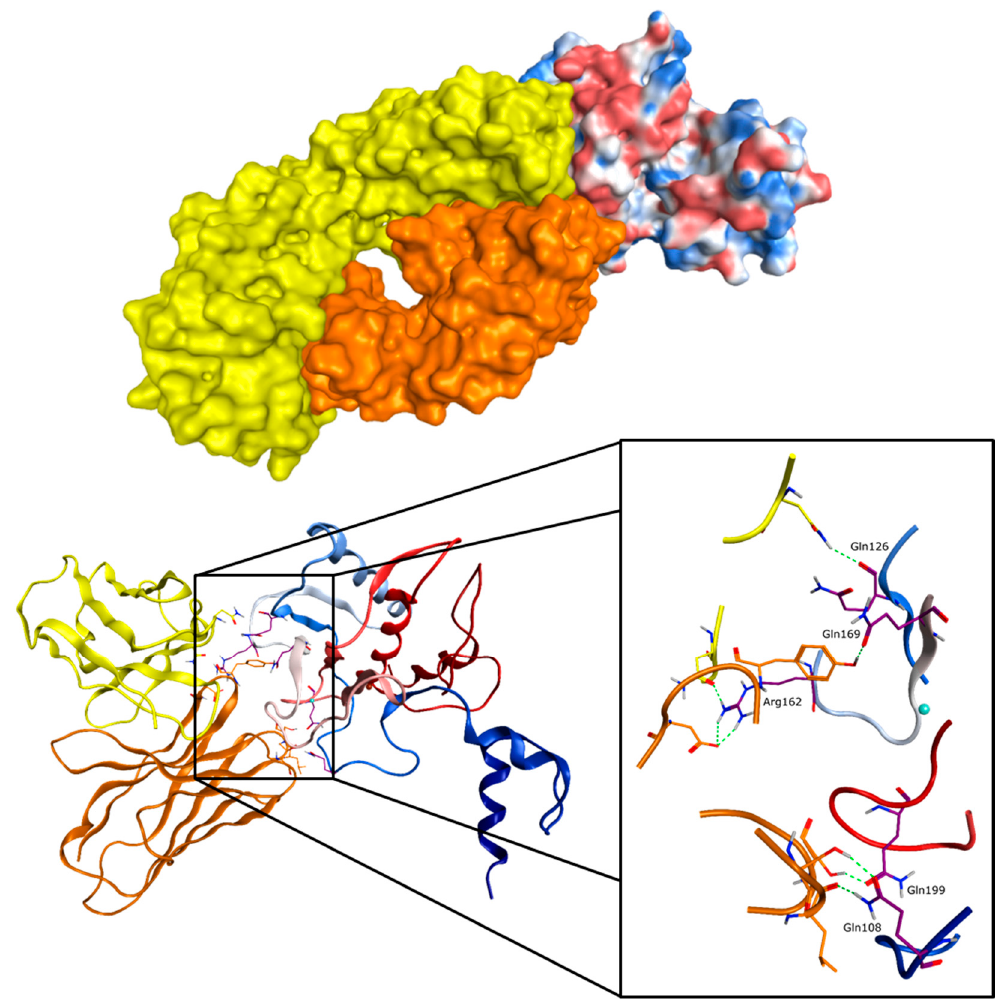
Figure 7. Crystal structure of GS-5745 Fab’ fragment complexed to MMP-9 and a close-up of the interaction site with the interacting side chains of MMP-9 (PDB ID: 5TH9 [19], GS-5745 Fab fragments in yellow and orange, and MMP-9 with electrostatic color surface).